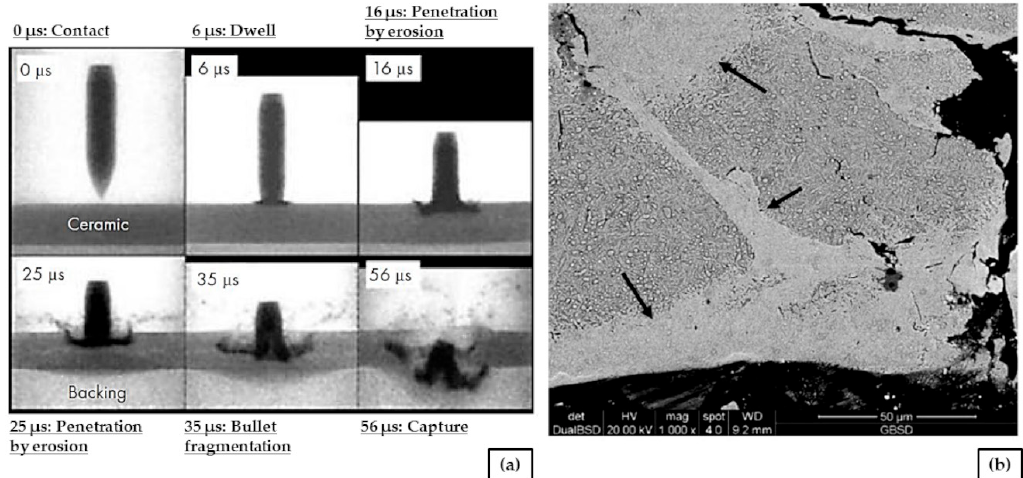
Figure 1. ( a ) Impact time history of a 7.62 mm APM2 projectile [3]; ( b ) post-test longitudinal cross-sectional view of a 7.62 mm Armour-Piercing (AP) projectile interacting with a boron carbide tile target (the black arrows indicate the shear bands) [4].